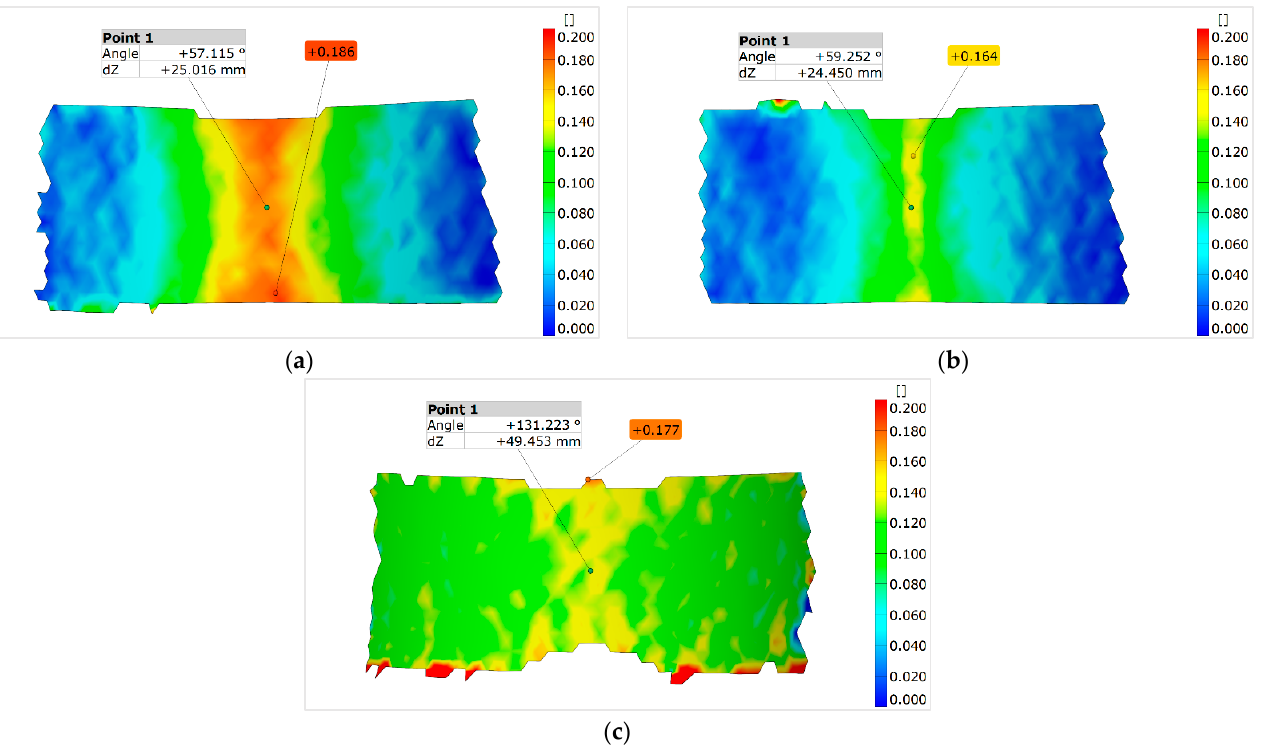
Figure 9. The correlation between FEM predicted and the experimentally measured relation between the force and the cross-head displacement for 4 mm sheet.